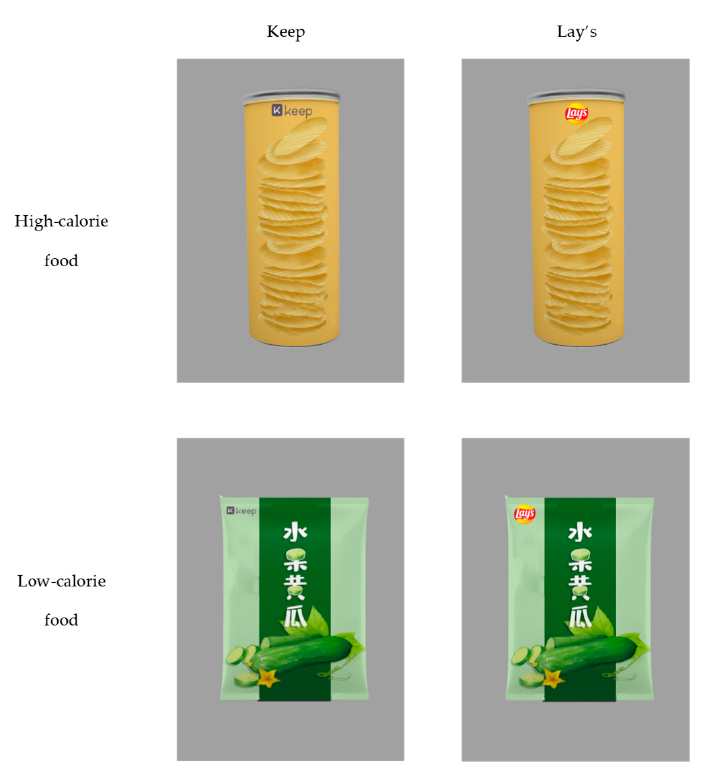
Figure A1. Examples of food pictures used in Study 1.